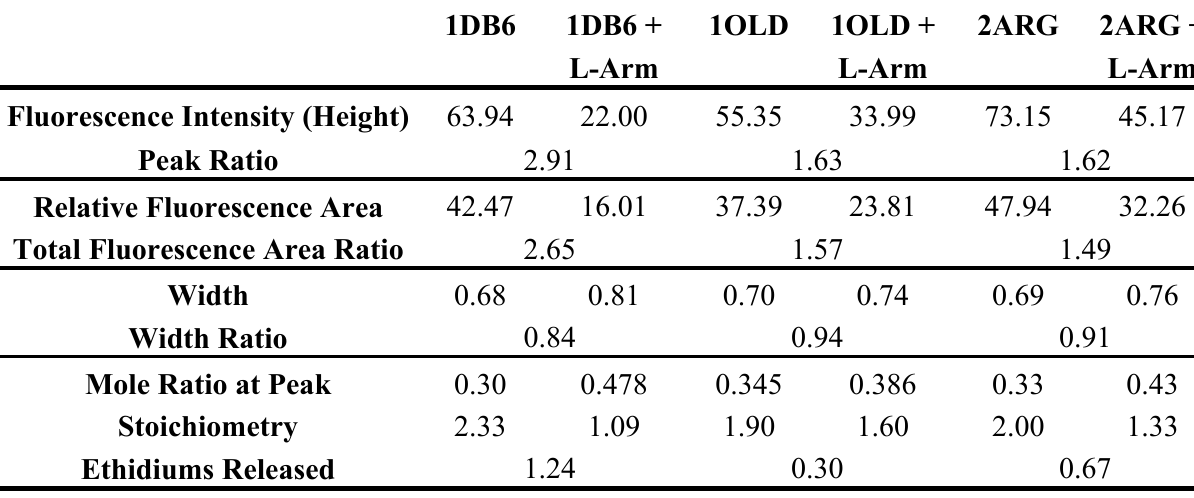
Table 4. Results from the method of continuous variations for the binding of ethidium to the L-argininamide binding DNA aptamers 1DB6, 1OLD, and